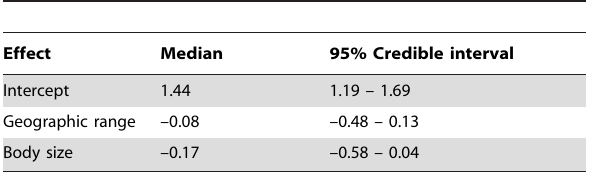
Table 2. Parameter estimates from the coefficient of variation model.